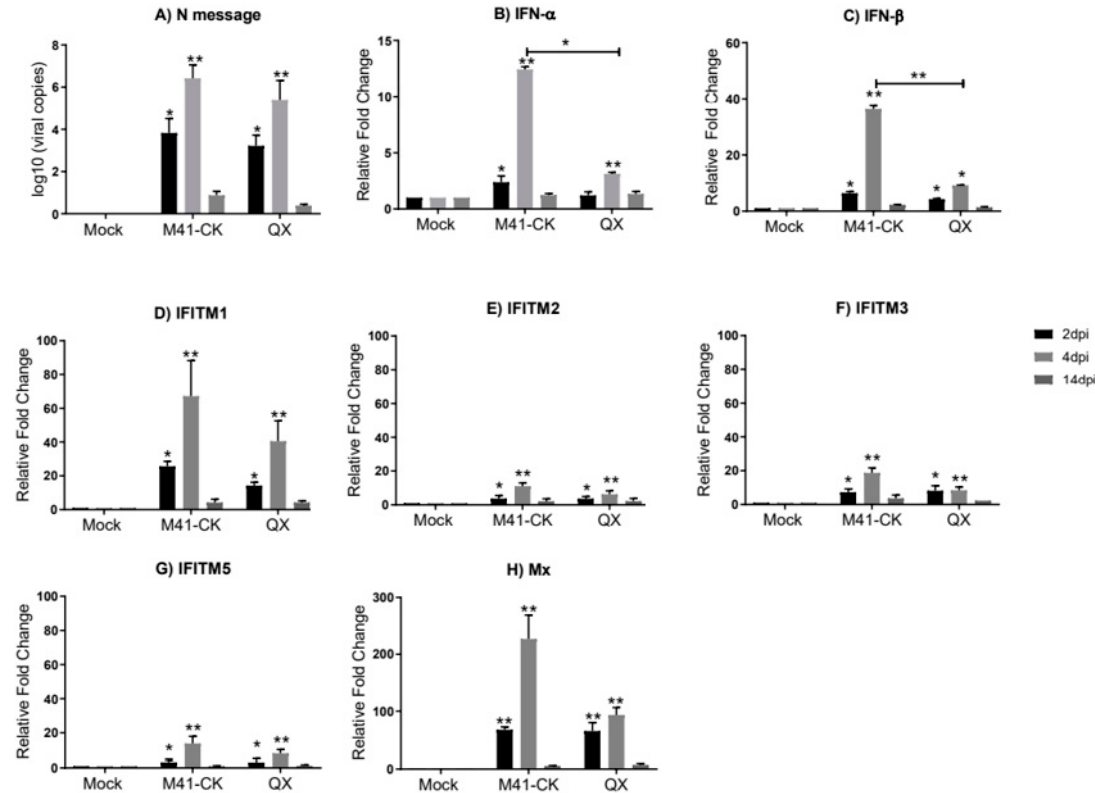
Figure 2. Relative expression of IFNs and chIFITMs in trachea samples from chickens infected with M41-CK and the nephropathogenic QX strain. ( A ) Log 10 of IBV RNA copies in trachea from chickens infected with pathogenic M41-CK or nephropathogenic QX, or mock infected, measured at 2, 4 and 14 dpi. Relative expression of ( B ) IFN- α , ( C ) IFN- β and ( D – G ) chIFITM1 , 2 , 3 and 5 and ( H ) Mx measured by qRT-PCR in tracheal samples collected at 2, 4 and 14 dpi from chickens experimentally challenged with M41-CK and QX IBV, or mock infected. Relative fold change was calculated using the ∆∆ CT equation, relative to mock and normalized to two reference genes, RPLPO and RPL13 . All graph values are the mean of three biological replicates with error bars as standard deviation. * indicates p < 0.05, ** indicates p < 0.01. ANOVA data were corrected for multiple comparisons using the Bonferroni adjustment method